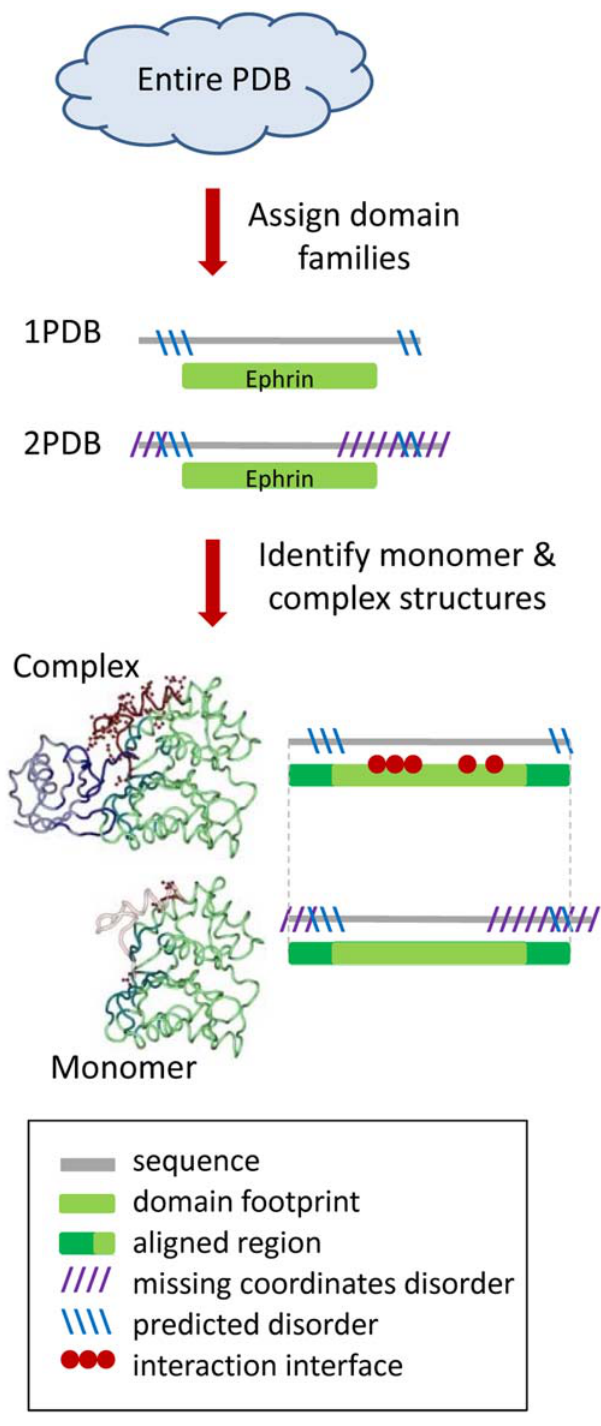
Figure 1. Flowchart showing the construction of the dataset.